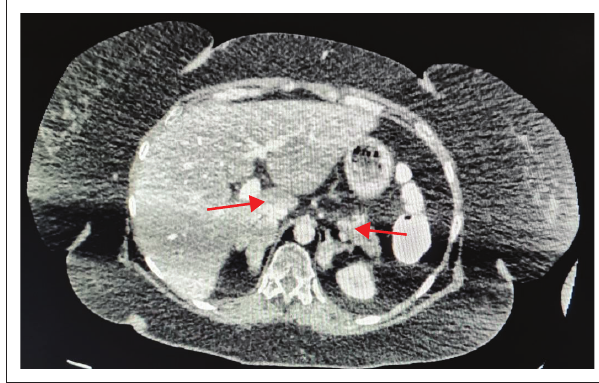
FIGURE 2: Computed tomography (axial view) demonstrating bilateral adrenal hyperplasia